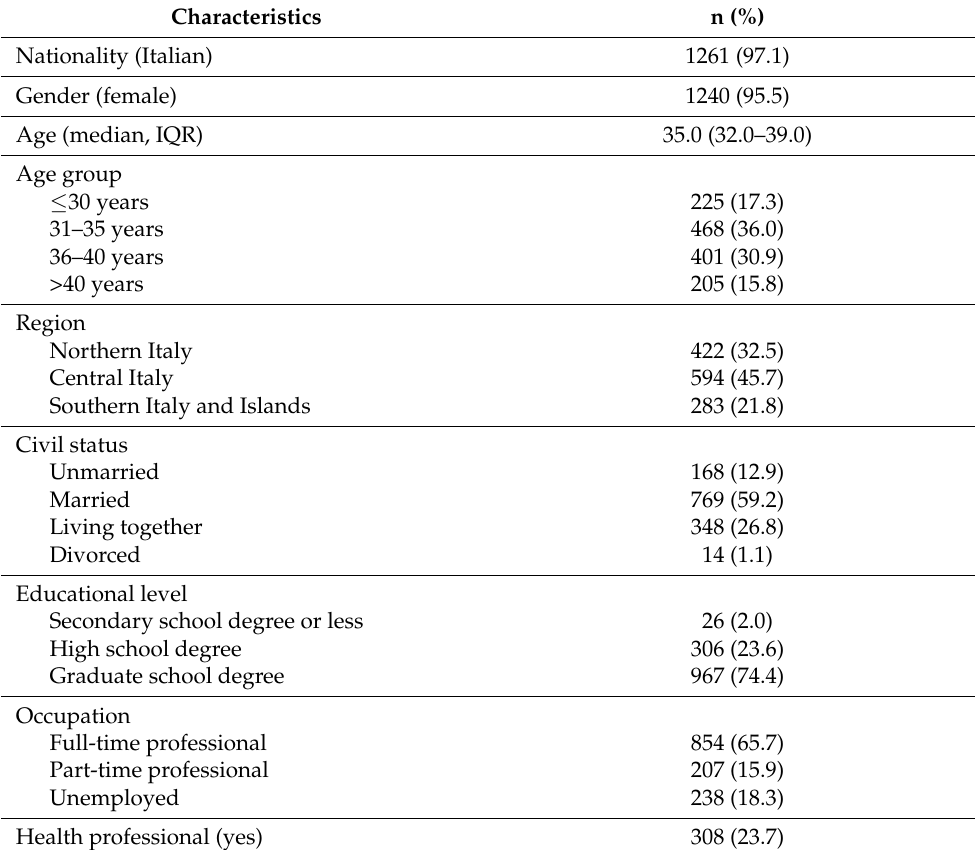
Table 2. Users sociodemographic characteristics (n =